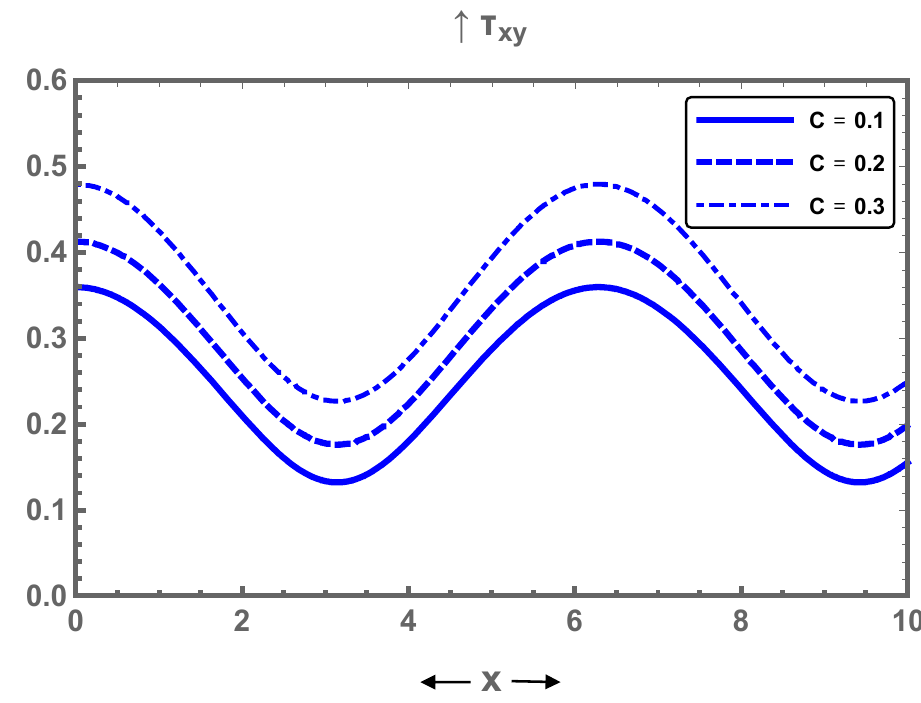
Figure 3. Display of shear stress profile for different values of C .